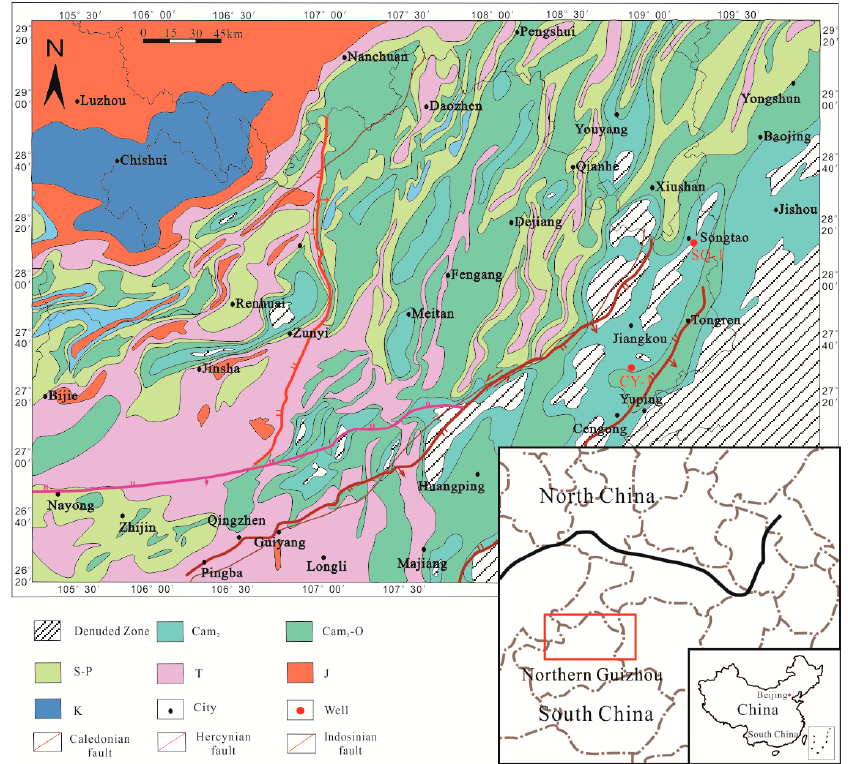
Figure 1. The simplified geologic map of the study area. Base map modified from [7].